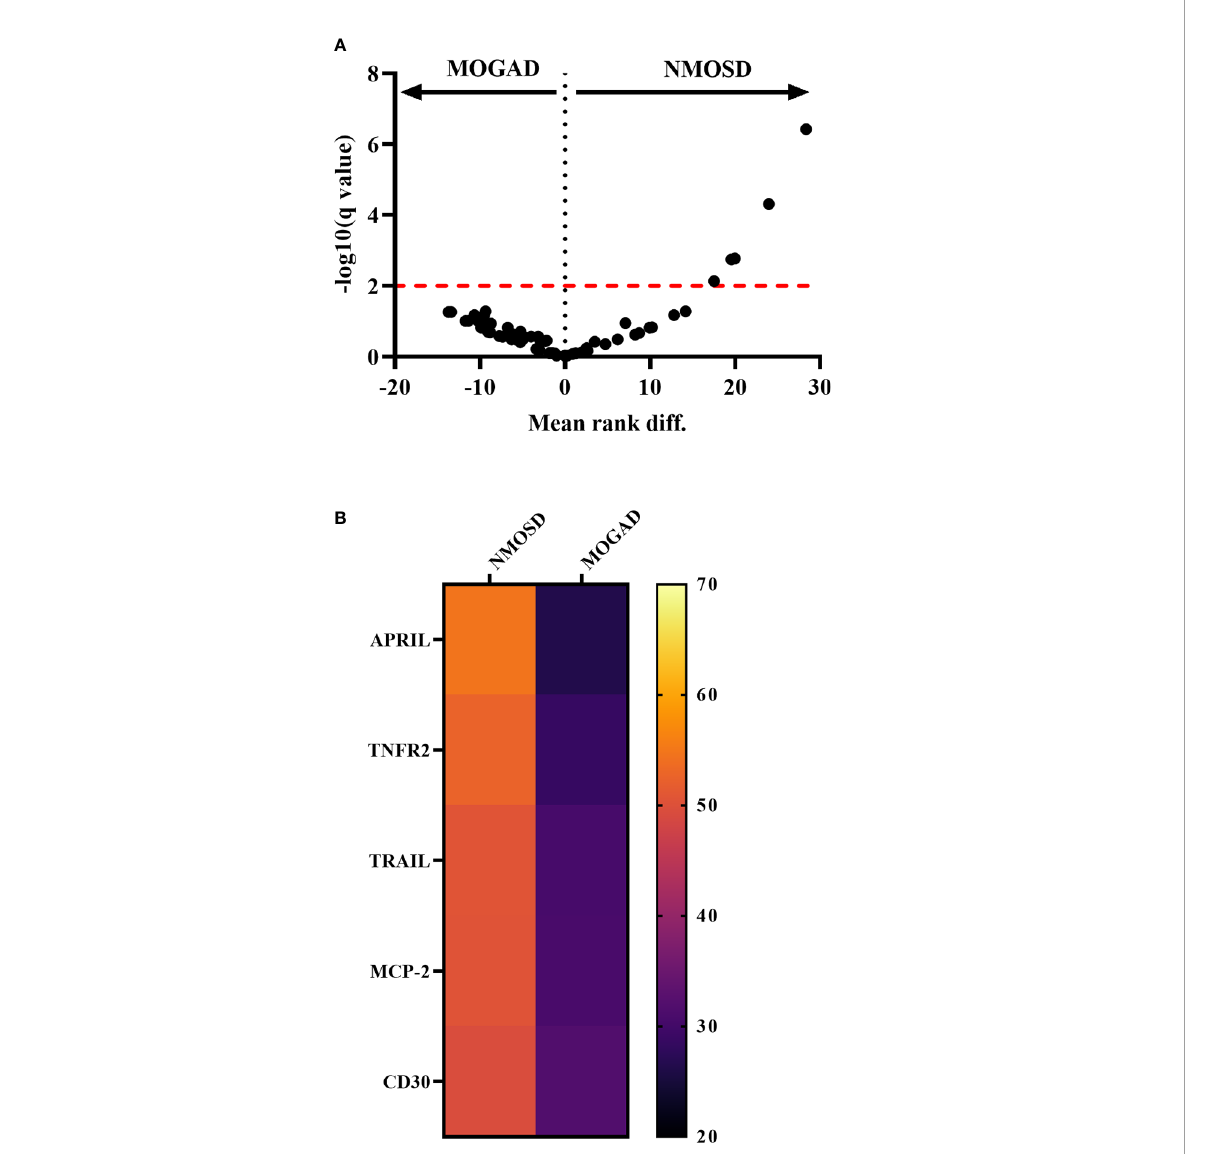
FIGURE 2 Comparison of cytokine, chemokine and related molecule levels between autoantibody-associated diseases. (A) Volcano Plot comparing MOGAD with NMOSD of all 65 cytokines, chemokines and related molecules measured by bead-based assay 1. Signi fi cant hits are shown above the signi fi cant level after correction for multiple comparisons using two-stage step-up (Benjamini, Krieger and Yekutieli) and FDR of 1% correction indicated as a red dotted line. (B) Heatmap showing mean ranks of signi fi cantly different cytokines, chemokines comparing MOGAD with NMOSD. APRIL, a proliferation-inducing ligand; BAFF, B cell activation factor; MCP, monocyte chemoattractant protein; MOGAD, myelin oligodendrocyte glycoprotein associated disease; MS, multiple sclerosis; NMOSD, neuromyelitis optica spectrum disorder; TNF, tumor necrosis factor; TRAIL, TNF-related apoptosis-inducing